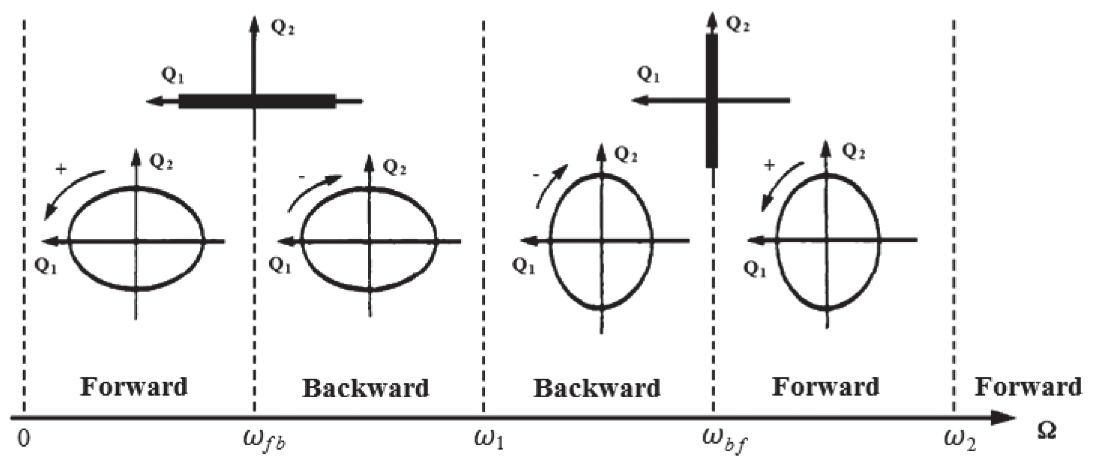
Figure 6 - variation of the whirl direction for an asymmetric rotor (adapted from Lalanne and Ferraris